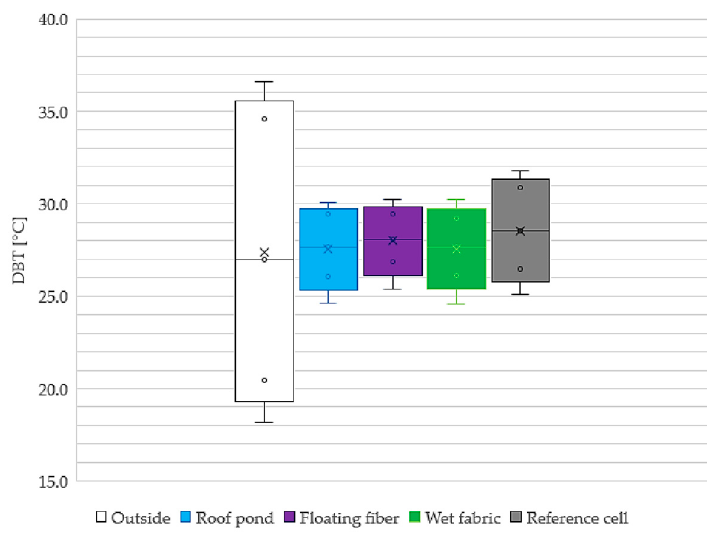
Figure 12. Box plot of the indoor air temperatures in the hot sub ‐ humid season.